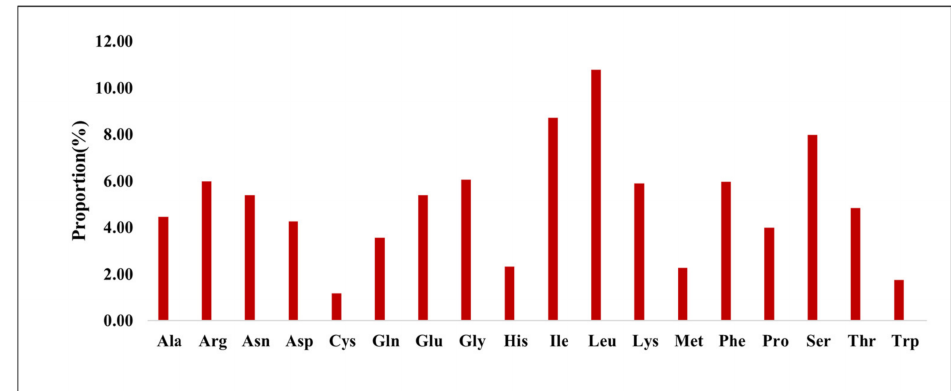
Figure 3. The frequencies of amino acids in Ficus populifolia